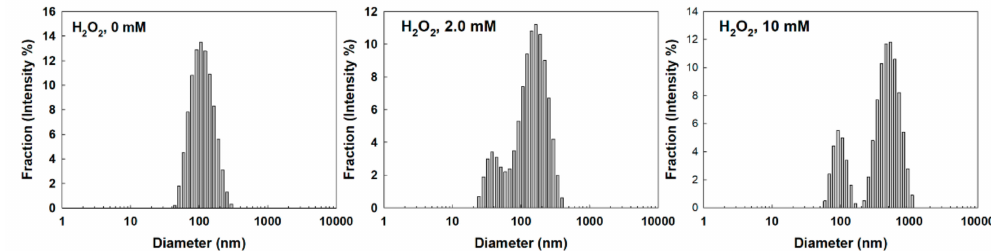
Figure 3. The effect of H 2 O 2 concentration on the changes in particle size distribution. To study ROS sensitivity, nanophotosensitizers in PBS (1 mg/mL) were incubated in the presence of H 2 O 2 at 37 ◦ C for 3